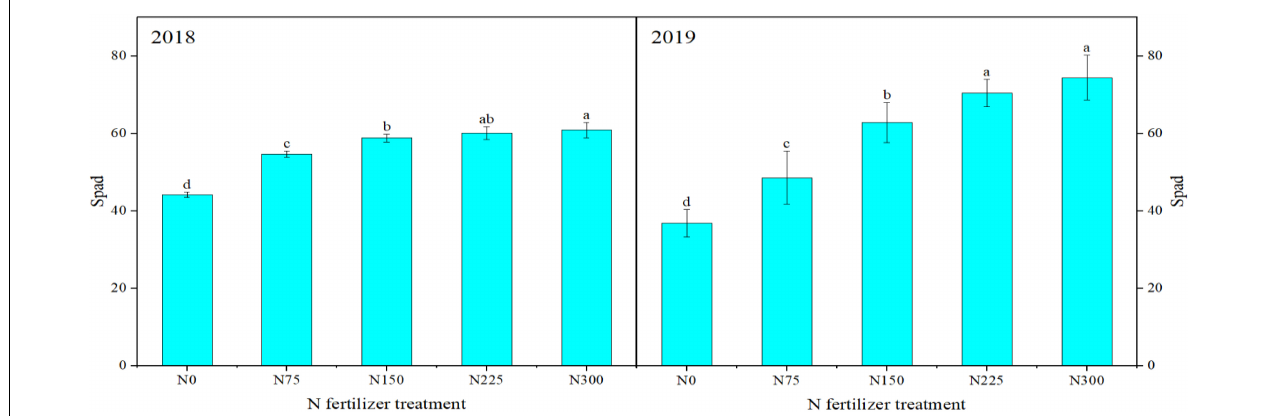
FIGURE 4 | Influence of different nitrogen (N) application rates on SPAD values at flowering stage in winter wheat during 2018 and 2019. Above bars, different small letters show significant differences among N treatments. N0: unfertilized control; N75: N application at 75 kg N · ha – 1 ; N150: N application at 150 kg N · ha – 1 ; N225: N application at 225 kg N · ha – 1 ; N300: traditional N application rate of 300 kg N · ha – 1 .